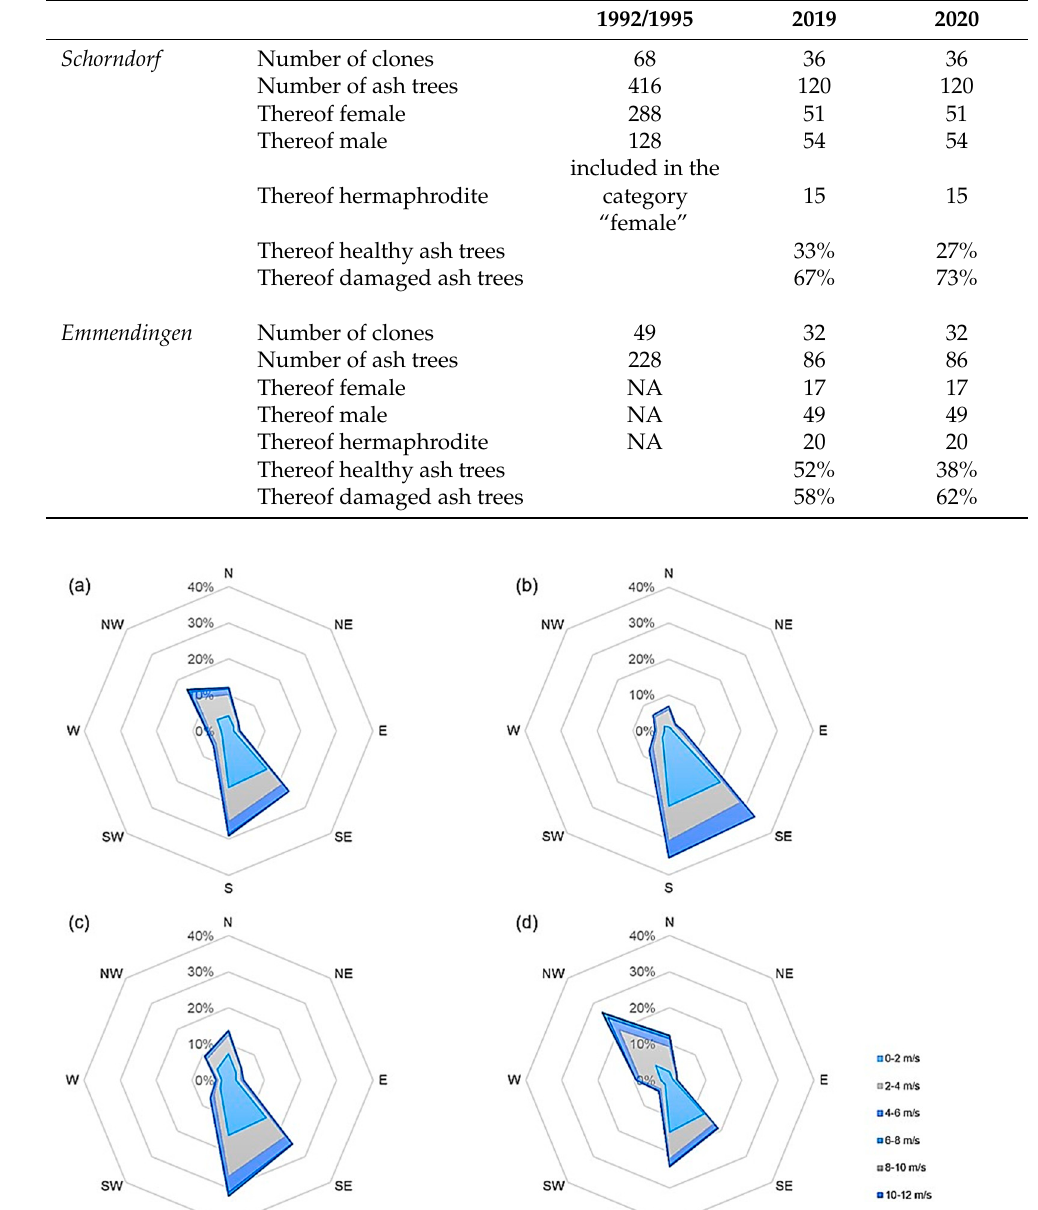
Figure A2. Wind rose during the measurement campaign in 2020 at the location Schorndorf for the periods ( a ) total: 18.03–13.05, ( b ) pre-flowering: 18.03–25.03, ( c ) main flowering: 25.03–22.04, ( d ) post-flowering: 22.04–13.05.